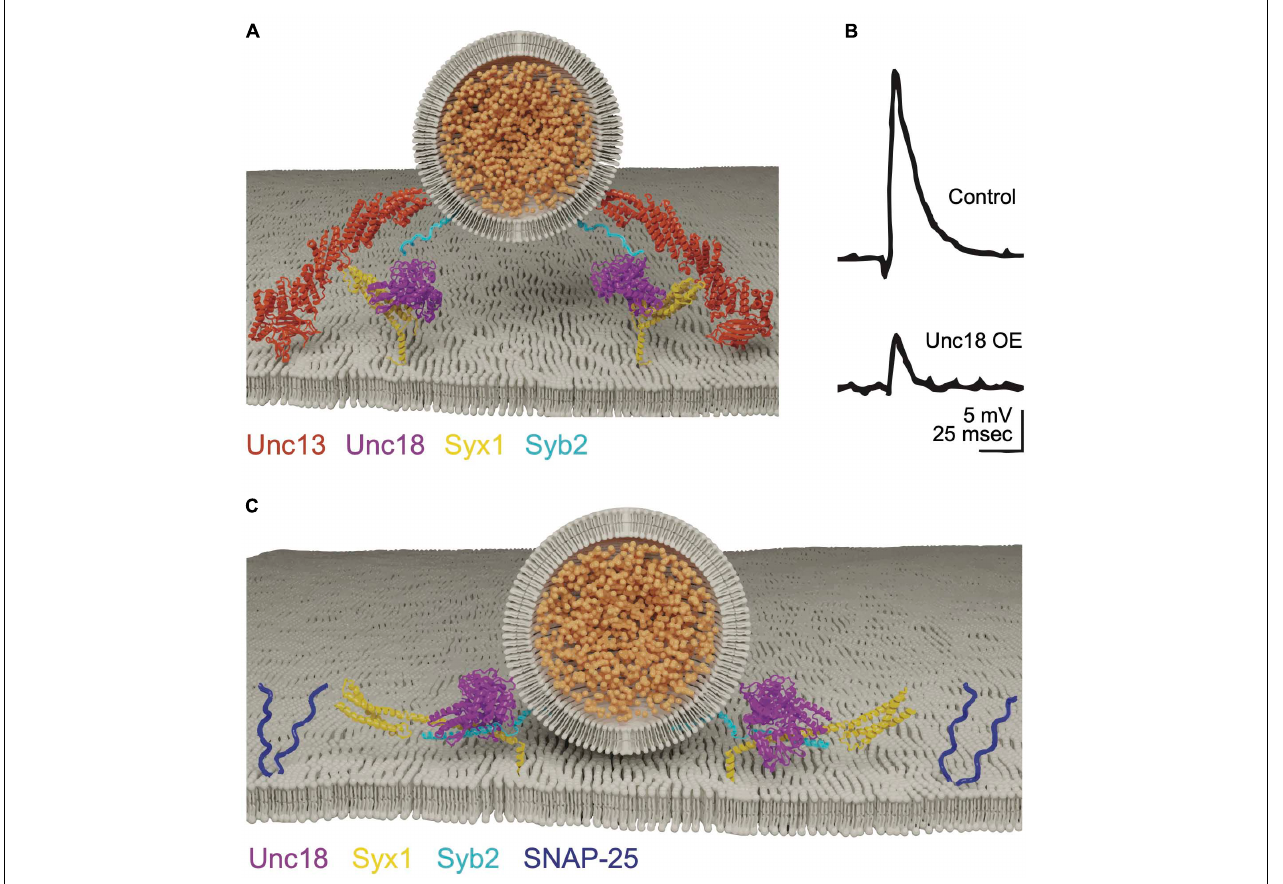
FIGURE 2 | Unc13 and Unc18 chaperone SNARE complex assembly by regulating Syx1. (A) Unc18 holds Syx1 in a closed conformation prior to SNARE complex assembly. Unc13 bridges the SV and plasma membranes and interacts with Syx1 to drive transition to the open-Syx1 state. Adapted from Burkhardt et al. (2008); Liu et al. (2016); Xu et al. (2018). (B) Electrophysiological recordings of evoked responses at the Drosophila larval neuromuscular junction reveal overexpression of Unc18 impairs SV fusion. Adapted from Schulze et al. (1994). (C) Unc18 chaperones the assembly of Syb2 and Syx1 prior to SNAP-25 inclusion into the SNARE complex. Adapted from Burkhardt et al.